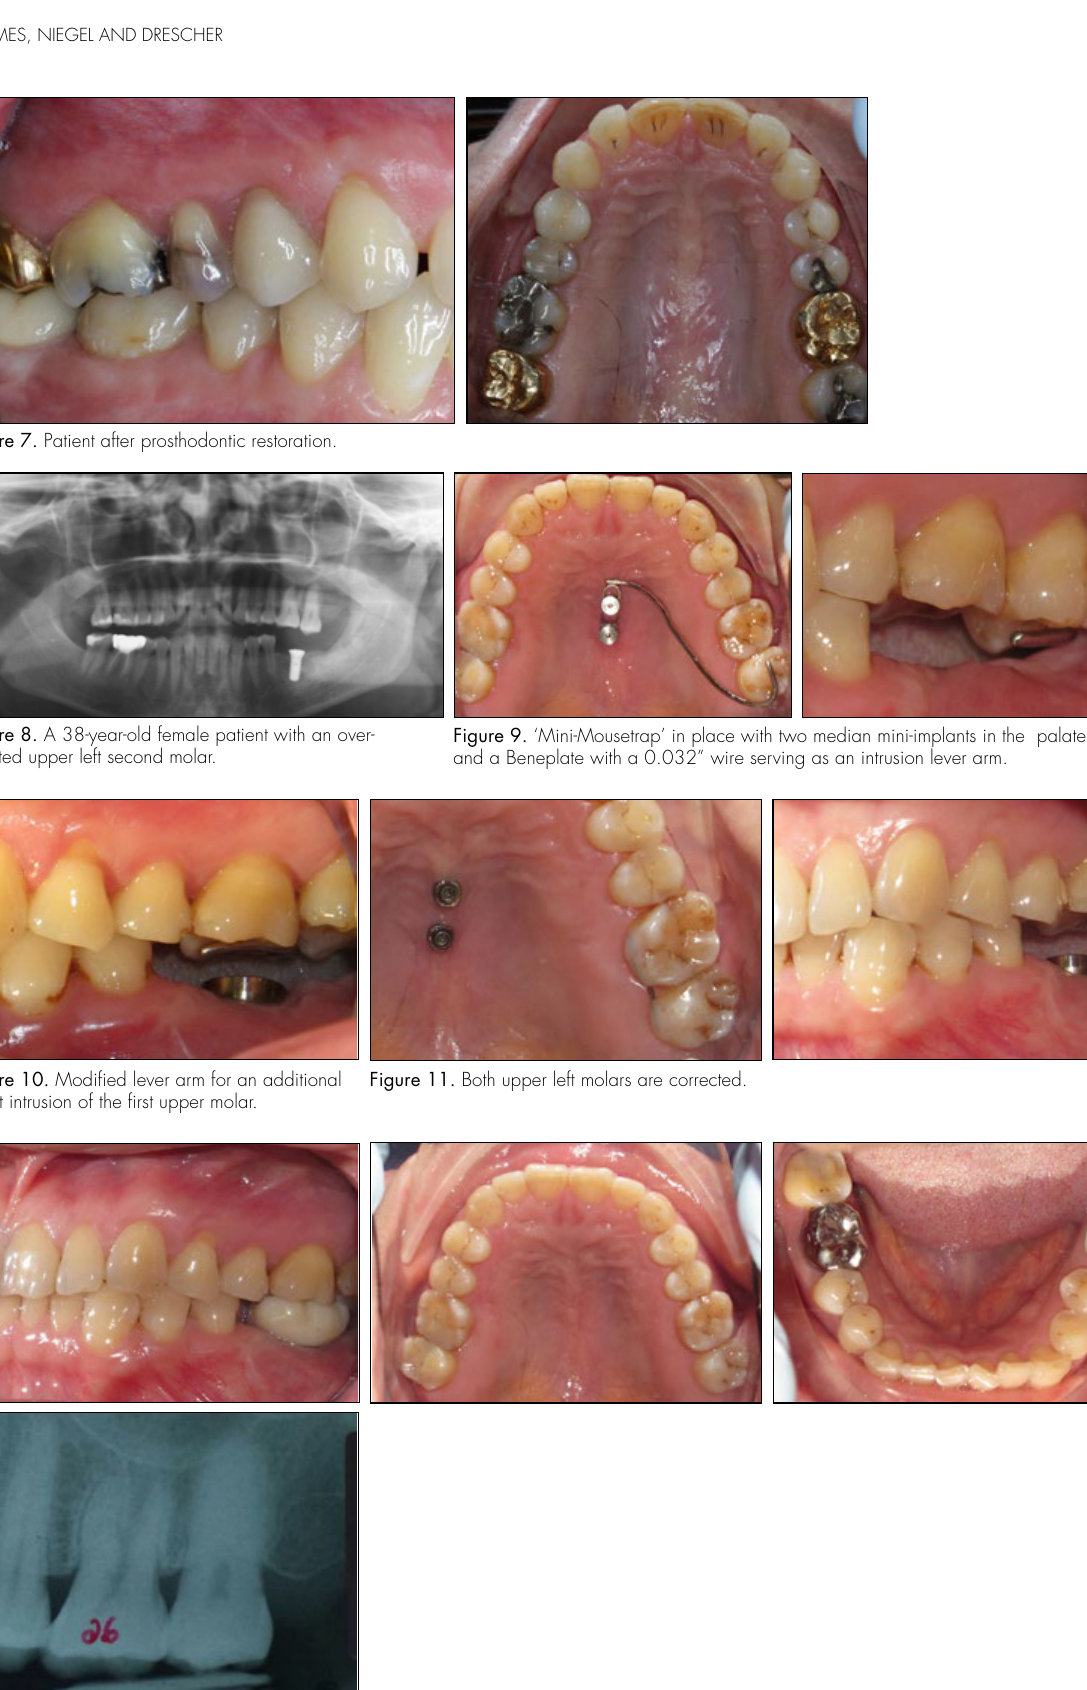
12d Figure 12. Patient after prosthodontic